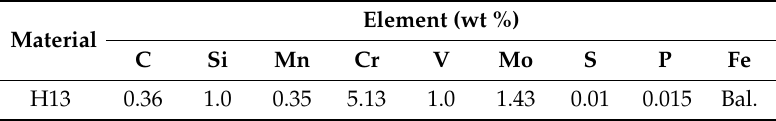
Table 1. Chemical composition of substrate steel